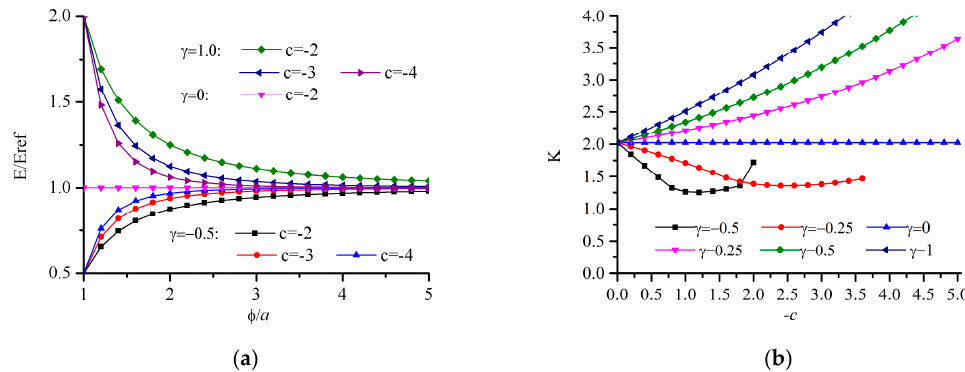
Figure 7. Variation of stress concentration factor K for power-law inhomogeneous variation of r-FGM when c < 0; ( a ) variation of Young’s modulus; ( b ) results for r-FGM.